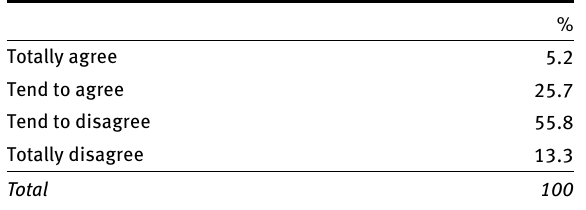
Table 4: The spread of robots in society will create safety problems.